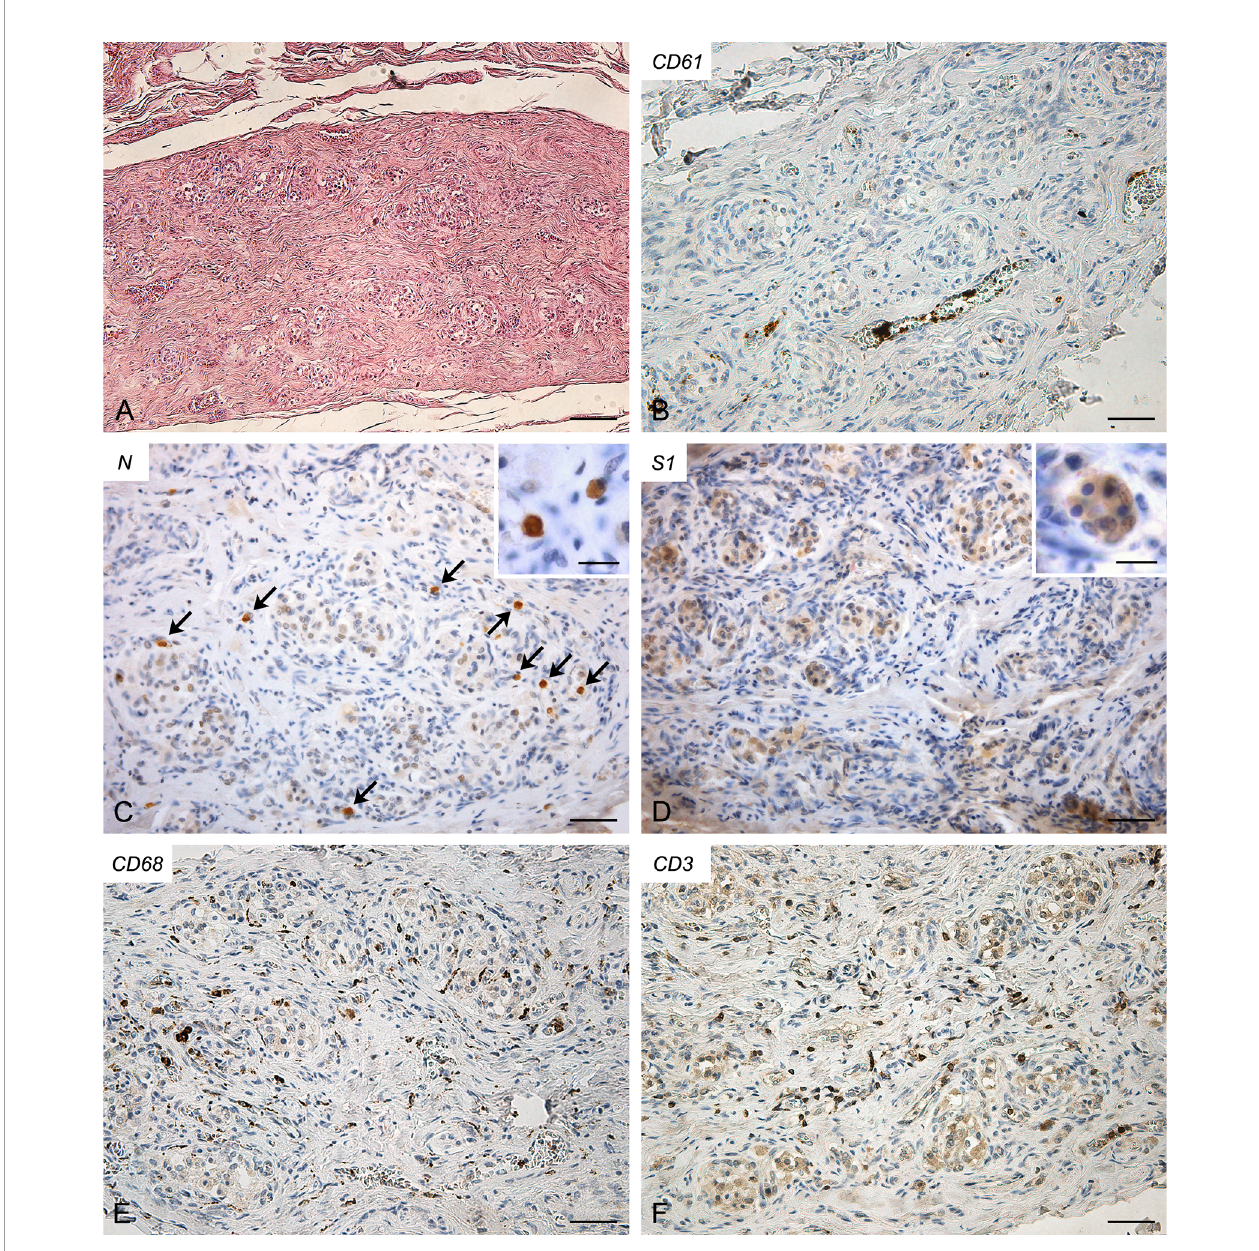
FIGURE 2 | Right carotid body of Case 2 – Haematoxylin-eosin (A) and immunohistochemitries for CD61 (B) , nucleocapsid ( C ; arrows: positive cells), Spike (D) , CD68 (E) and CD3 (F) . Scale bars: 100 µm (A) ; 50 µm (B – F) . Inserts: high magni fi cation of positive type I cells; Scale Bar: 15